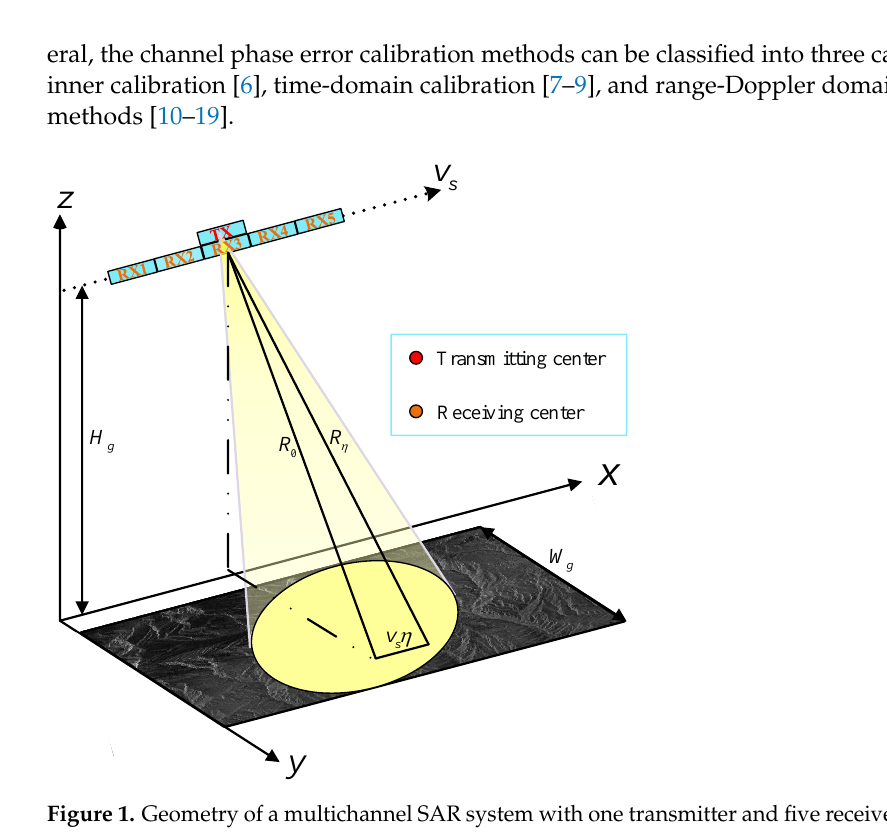
Figure 1. Geometry of a multichannel SAR system with one transmitter and five receivers in